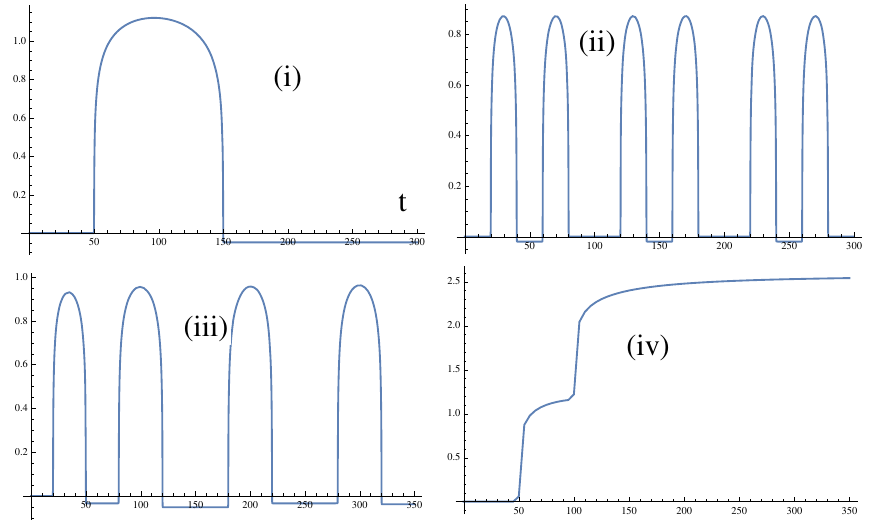
Figure 44 . The time evolutions of EE in the Dirac Fermion CFT for the choices (i), (ii), (iii), (iv) of subsystem A . We chose b = 50 and a = 0 : 05 (corresponding to s = 5 : 28 : : : ( >